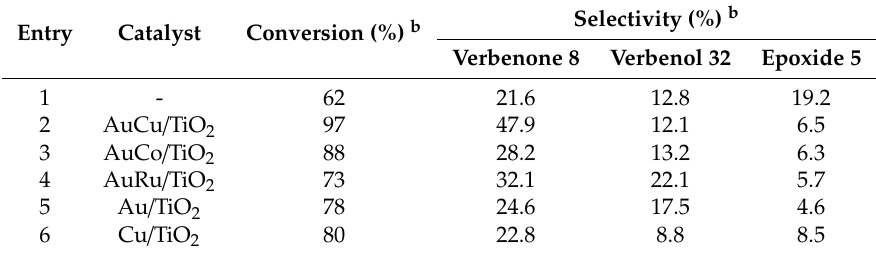
Table 18. Oxidation of α -pinene. Comparison of various gold containing mono- or bi-metallic nanoparticles supported on TiO 2 a (adapted from reference [65]).